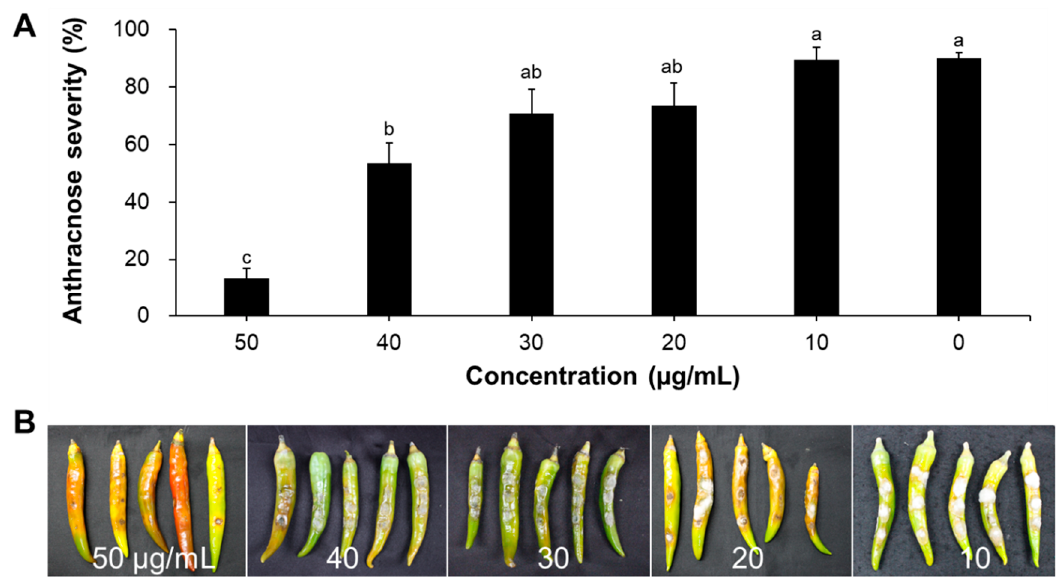
Figure 6. Antifungal activity of iturinic lipopeptides isolated from B . subtilis KB21. ( A ) Disease severity of pepper anthracnose upon treatment with fractioned lipopeptides (10, 20, 30, 40, and 50 µ g/mL). ( B ) Photo taken seven days post-inoculation. Data are means ± standard errors of three replicates. The values followed by different letters in a column were significantly different at p < 0.05 by Duncan’s multiple range test.